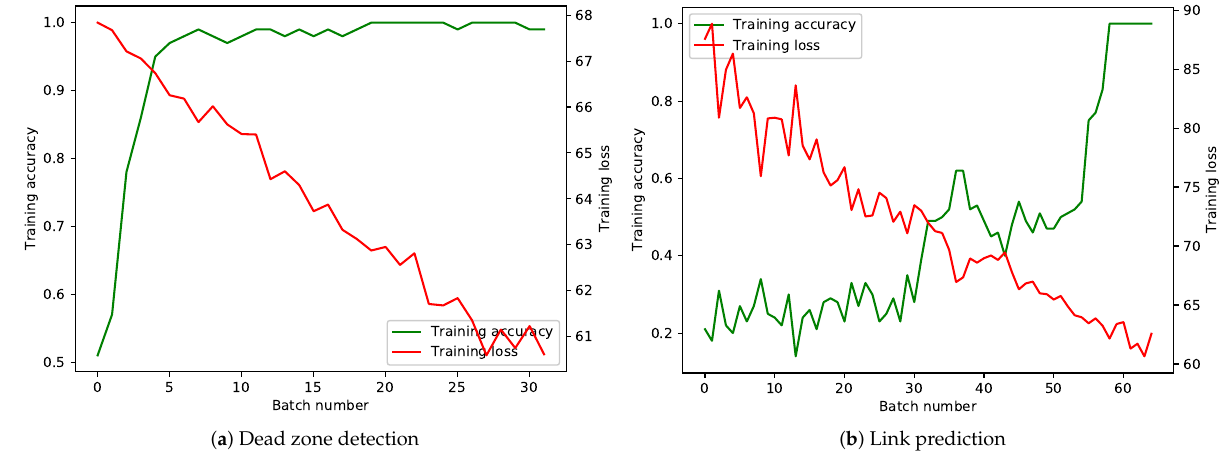
Figure 5. Training curves for dead zone detection and link prediction.